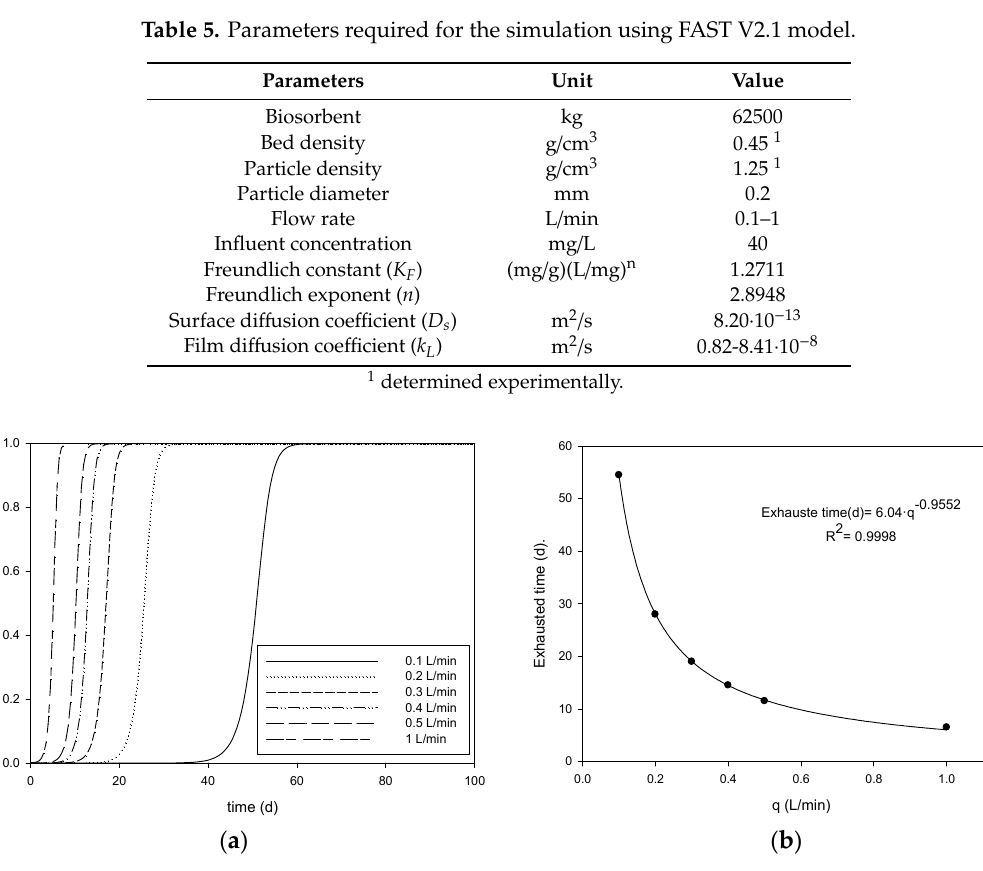
Figure 6. Breakthrough curves obtained from the FAST v2.1 simulation: ( a ) at different flow rates; ( b ) exhaustion bed time versus flow rate.